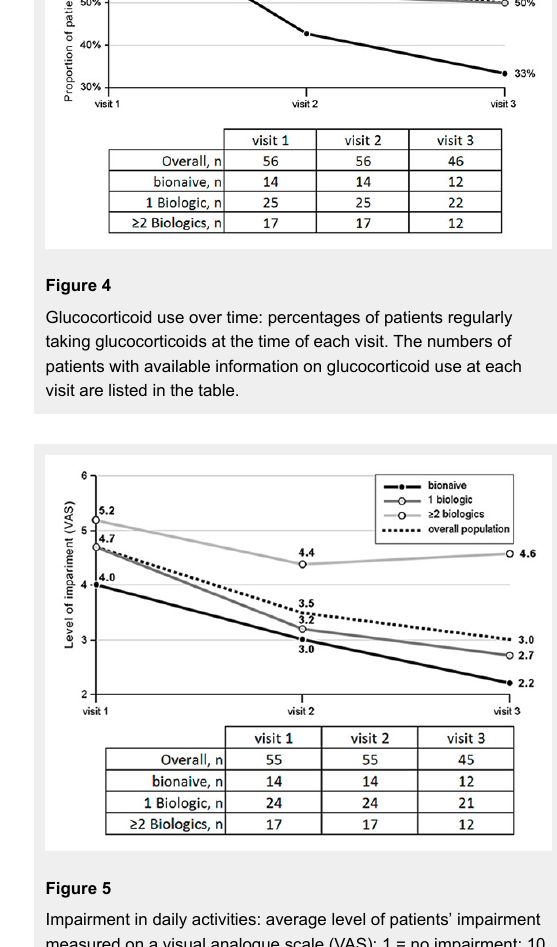
Impairment in daily activities: average level of patients’ impairment measured on a visual analogue scale (VAS): 1 = no impairment; 10 = severe impairment. The numbers of patients with available assessments at each visit are listed in the